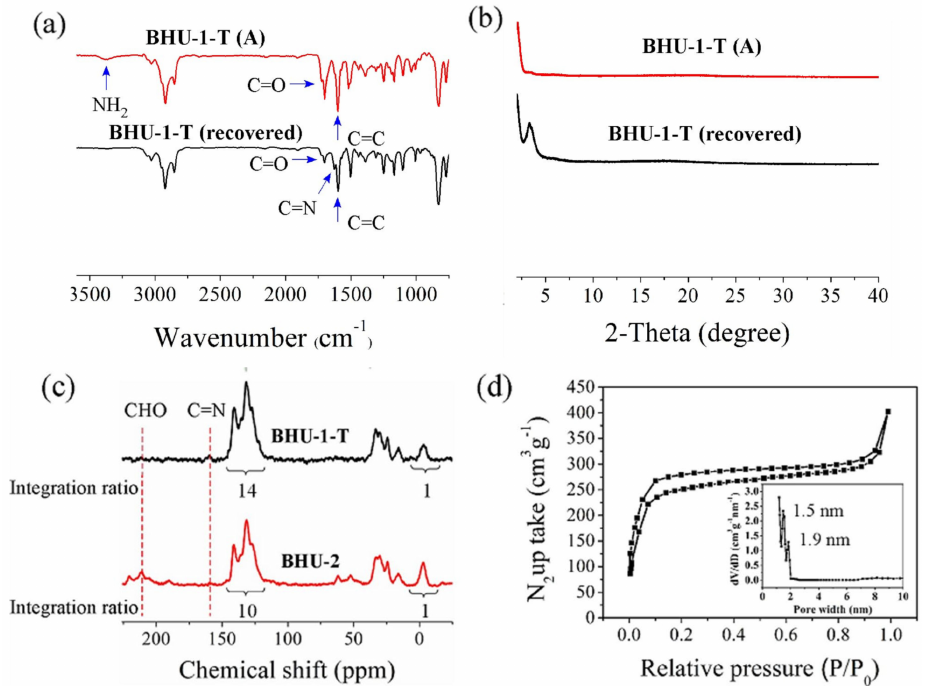
Figure 4. ( a ) IR spectra and ( b ) PXRD patterns of BHU-1-T(A) (above) and BHU-1-T (recovered) after heating. The 1600 and 1700 cm − 1 peaks were assigned to the aromatic rings and aldehyde groups respectively. The presence of some unreacted aldehyde in the formed COFs was commonly known [28–31]. ( c ) 13 C CP-MAS solid-state NMR spectra of BHU-1-T and BHU-2 (the peaks at 50 ppm belong to the methanol solvents trapped with BHU-2). ( d ) Nitrogen adsorption–desorption isotherms and pore-size distribution of